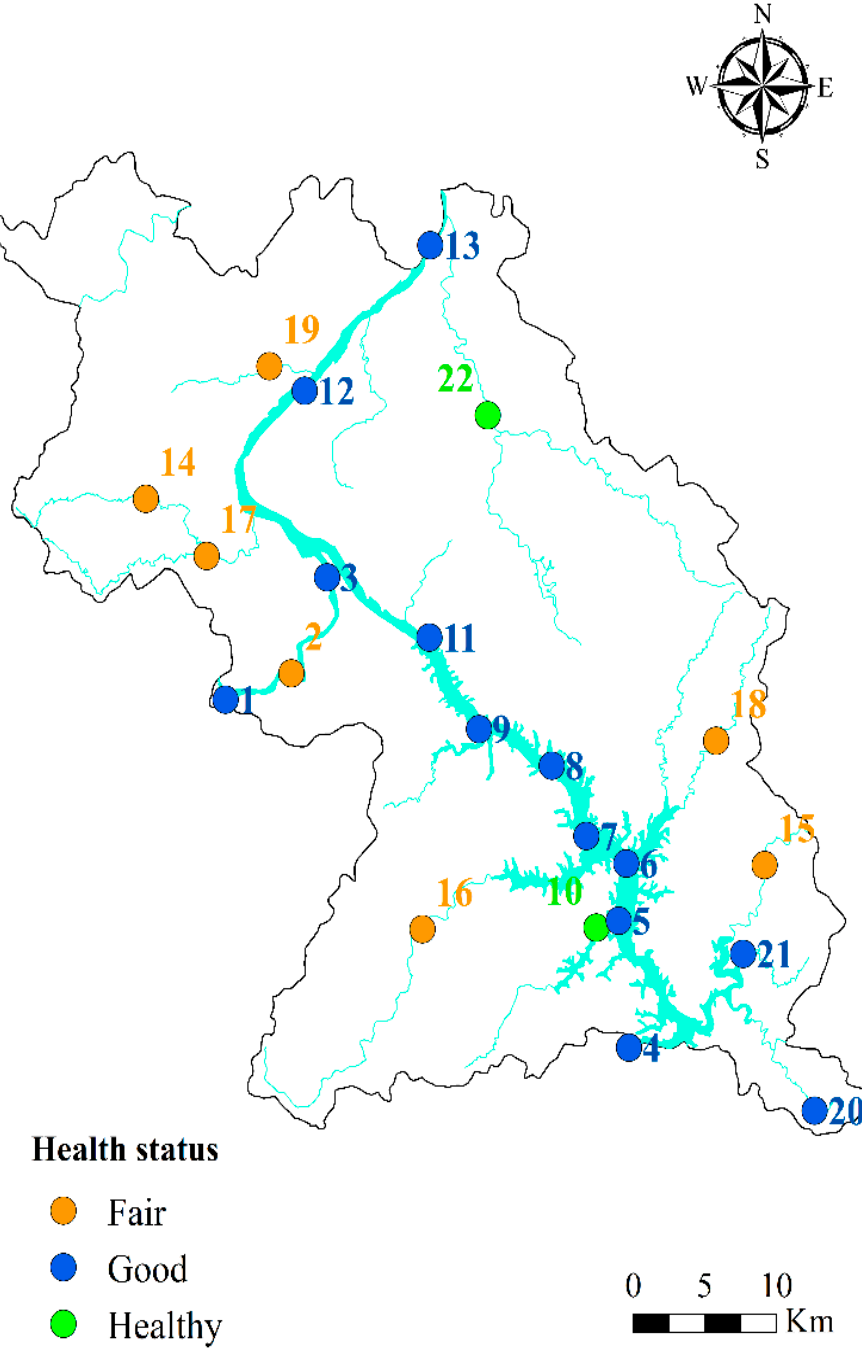
Figure 5. The spatial distribution of Z-IBI values in the Wanan River basin, China.